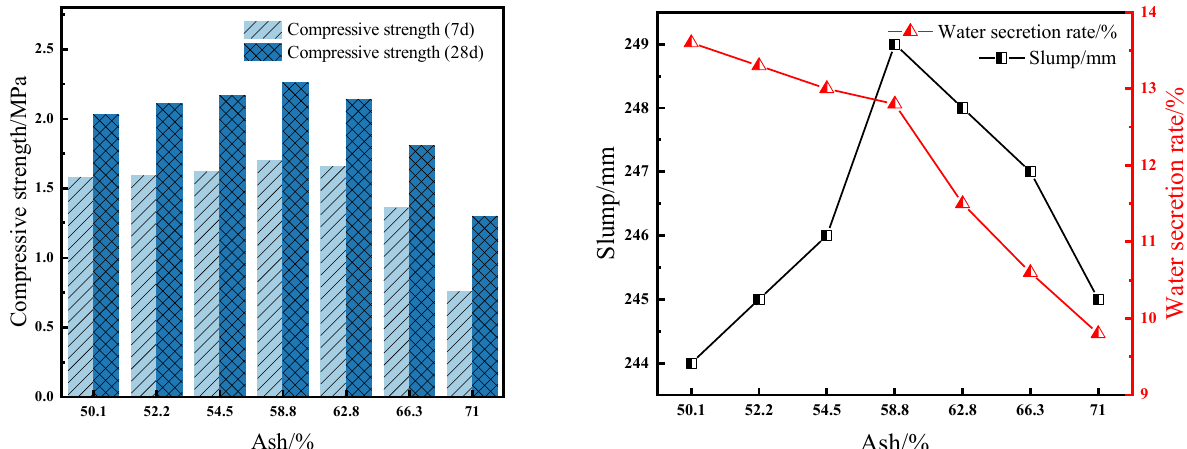
Figure 3. Effect of ash on CFTFM performance.